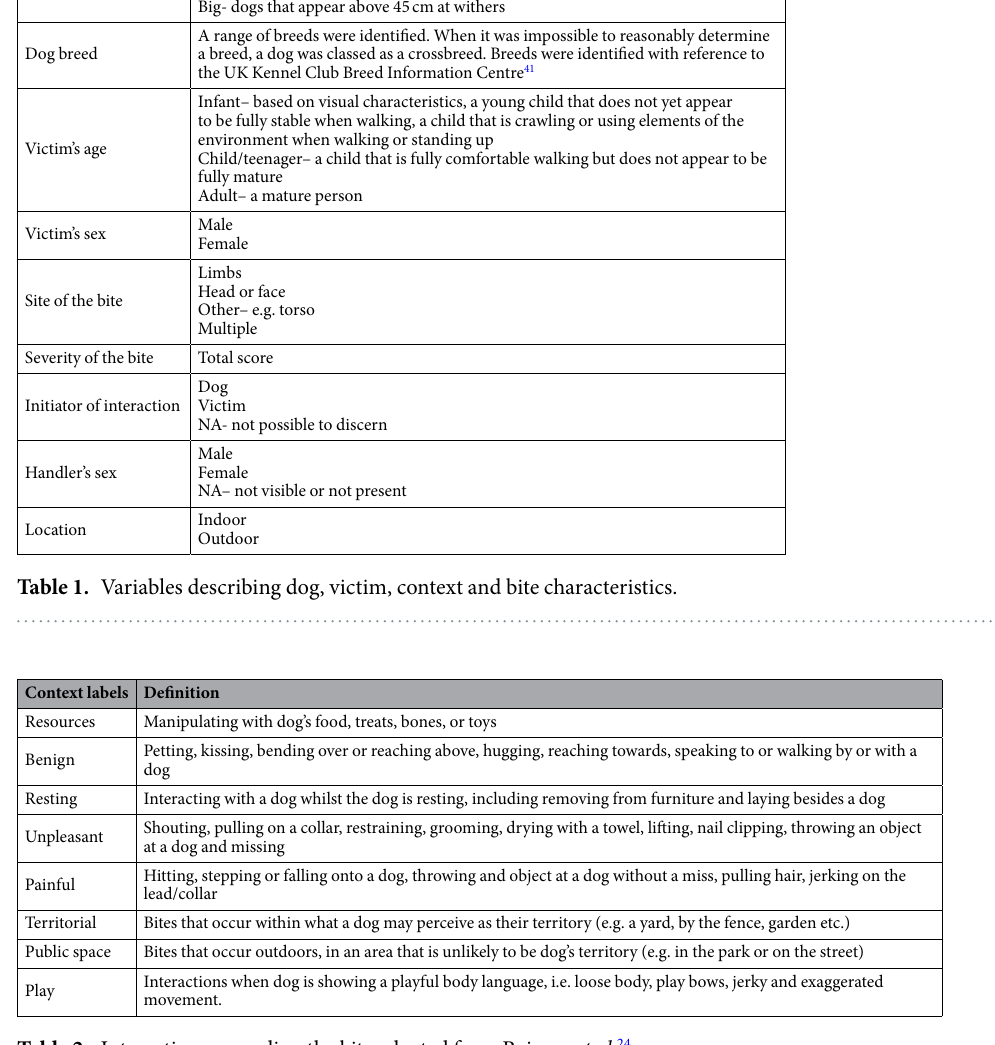
Table 2. Interactions preceding the bite adapted from Reisner et al . 24